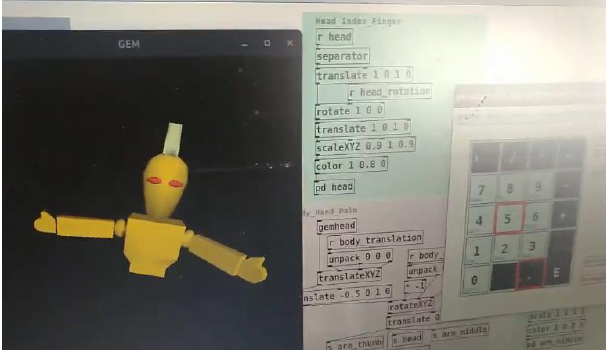
Figure 13. Virtual Puppet’s Pure Data/GEM version with Katja’s puppet reinterpreted and 3D modeled by Hugo Jácome.